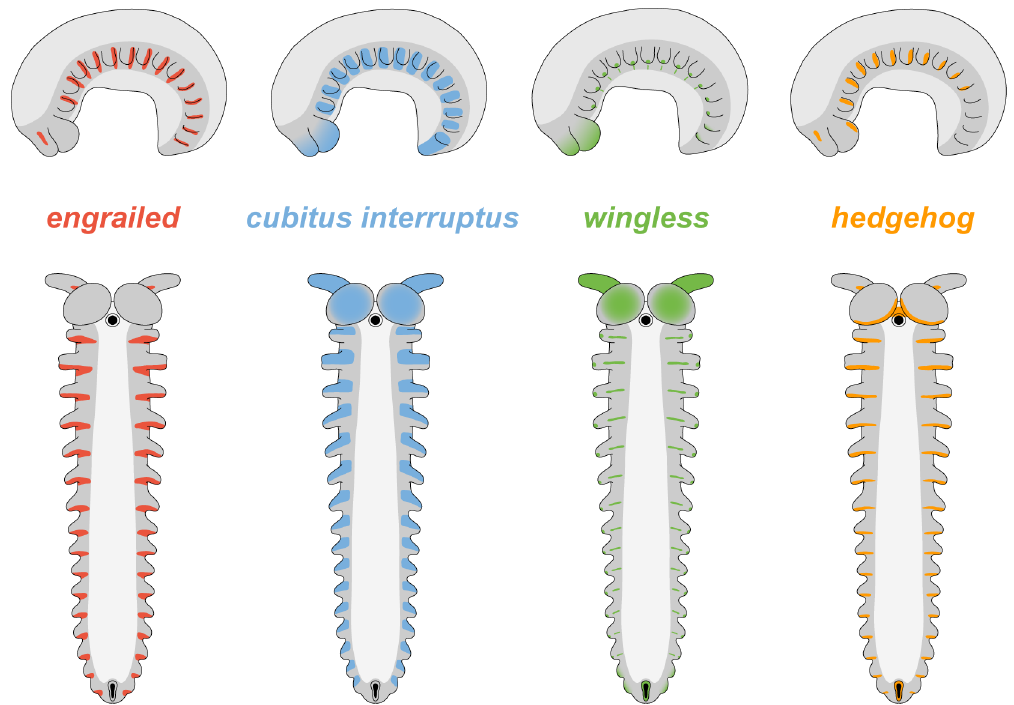
Figure 12. Diagrams of engrailed , cubitus interruptus , wingless and hedgehog expression in embryos of the onychophoran E. rowelli . The upper row illustrates stage III embryos in lateral view, whereas the lower row shows stage IV embryos in ventral and lateral views, respectively. Note the segmentally repeated patterns of expression of all four ‘‘segment polarity genes’’ and their specific order within each segment (see text for further details).